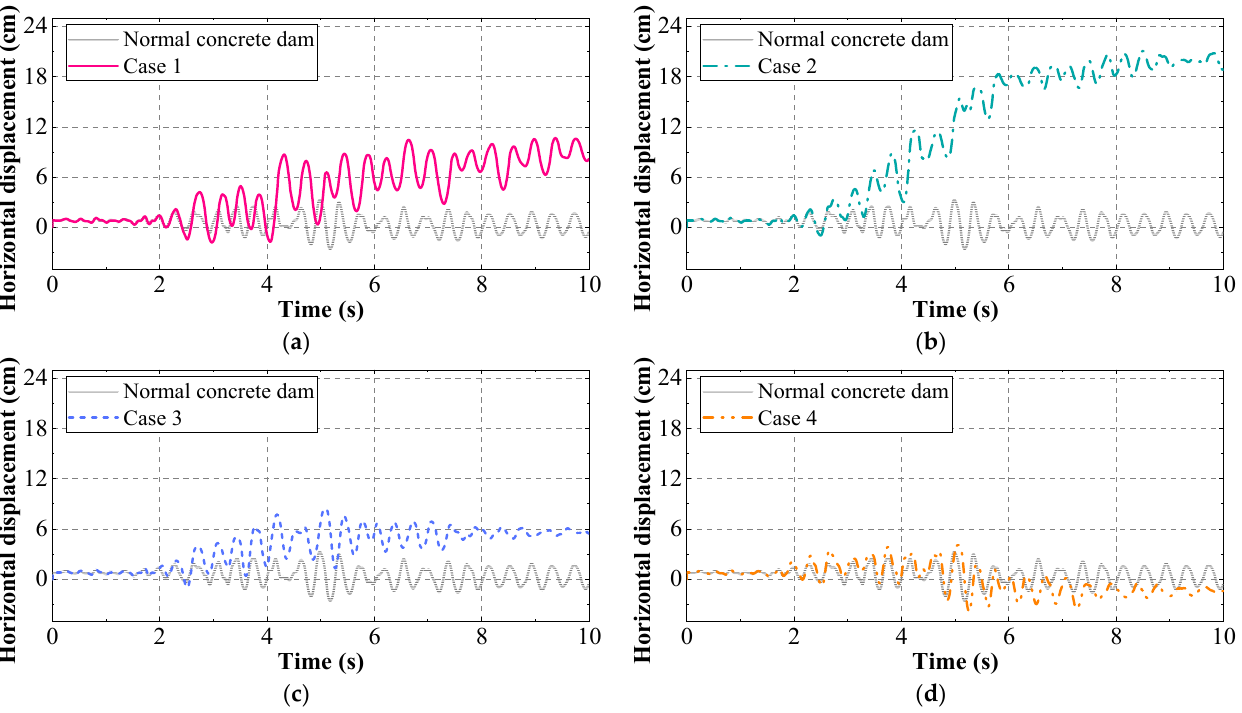
Figure 10. Horizontal displacement responses of the dam crest. ( a ) Case 1; ( b ) Case 2; ( c ) Case 3; ( d ) Case 4.